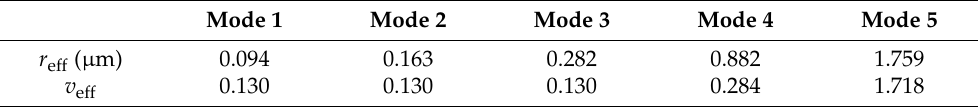
Table 2. Definition of the effective radius ( r eff ) and the effective variance ( v eff ) in the retrieval.